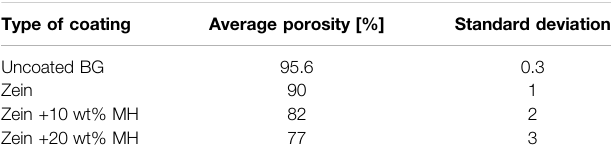
TABLE 1 | Porosity of uncoated and coated BG scaffolds.